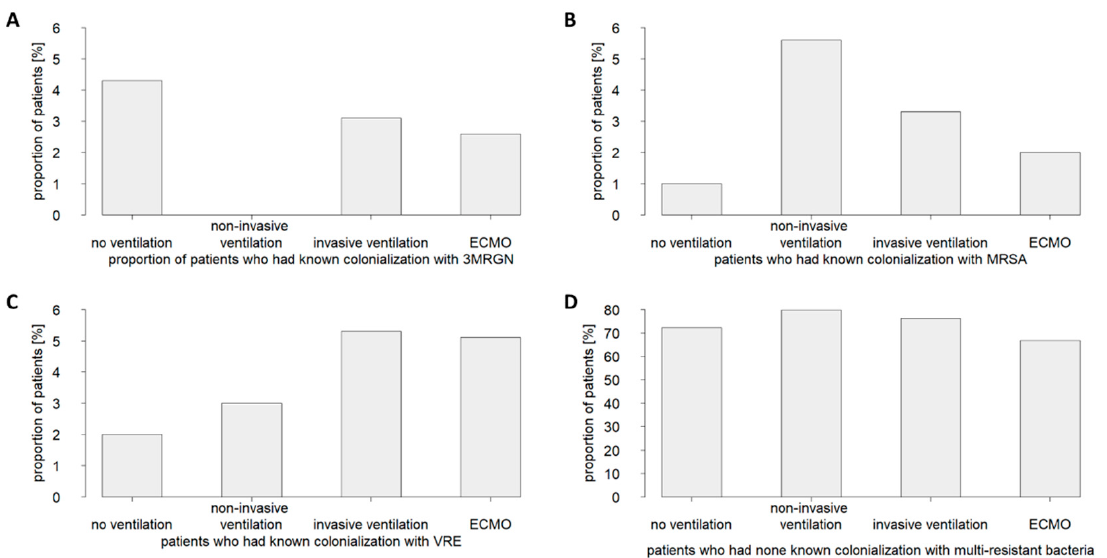
Figure 1. Prevalence of community-acquired colonializations with multidrug-resistant bacteria in patients critically ill with COVID-19 who received no ventilation therapy or were treated with non-invasive ventilation, invasive ventilation, or ECMO (extracorporeal membrane oxygenation). Shown are the proportions of patients who were colonized with ( A ) 3MRGN (multidrug-resistant Gram-negative bacteria), ( B ) MRSA (methicillin-resistant Staphylococcus aureus ), or ( C ) VRE (vancomycin-resistant enterococci), or those where ( D ) no colonization was found.